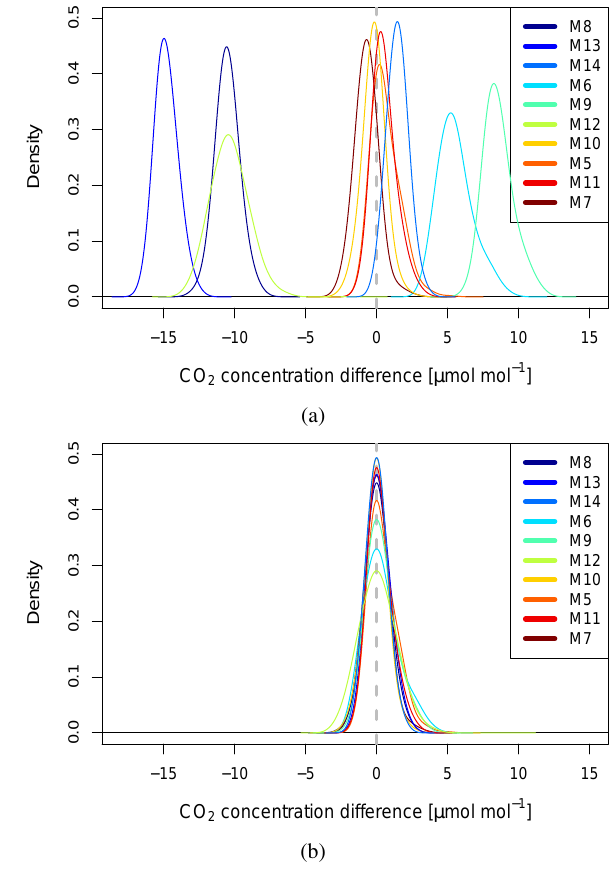
Fig. 6. Calibrated CO 2 concentration time series, before bias cor- rection (a) and after bias correction with MI c =0 . 12 (b) , measured at ten sub-canopy locations M5 , M6 ,..., M14 at a 2.25m height with a 1Hz resolution on 29 June 2008.